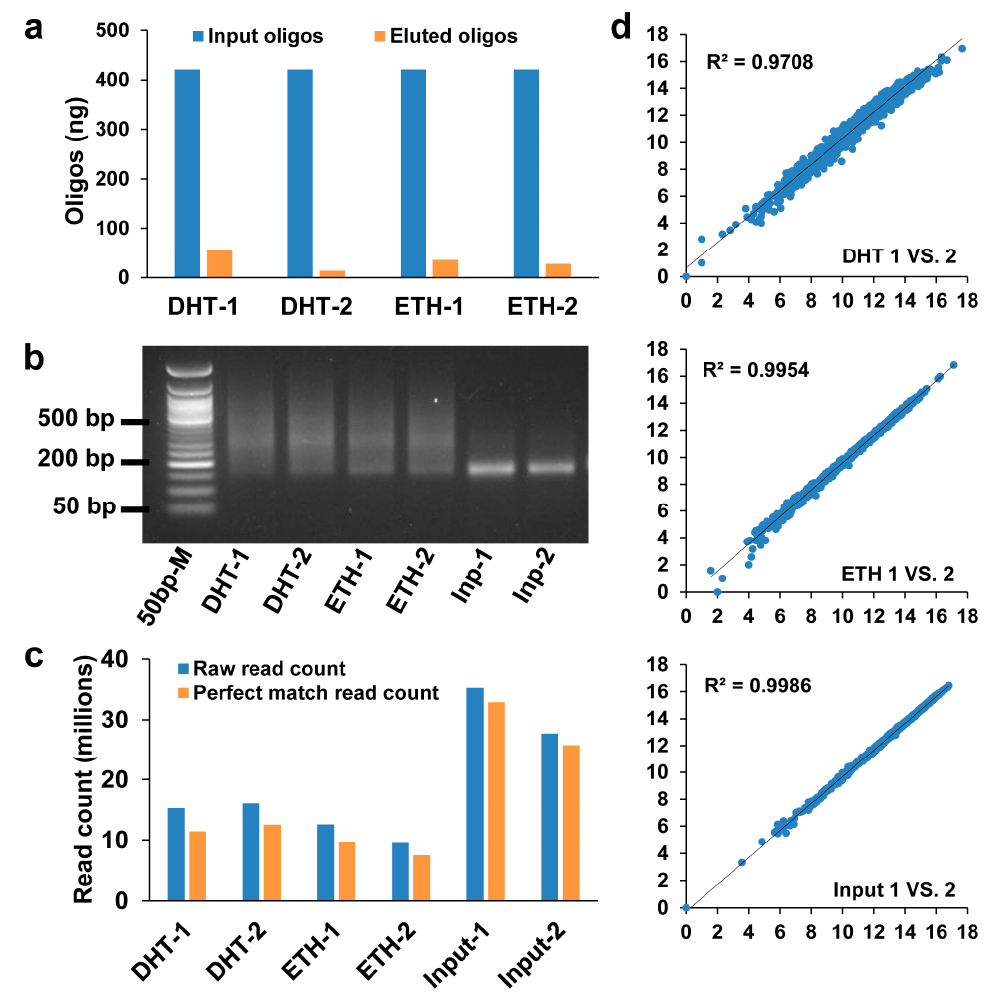
Figure 2. Quality control of SNPs-seq. ( a ) Eluted oligos after protein–DNA binding assay accounted for 3–13% of original input oligos. ( b ) Sizes of SNPs-seq libraries were ~160 bp in the input group and 150–500 bp in the test group. ( c ) Raw read counts and perfect match read counts in test and input samples. ( d ) Correlation of raw read count at log2 values between technical replicates in dihydrotestosterone (DHT), ethanol (ETH), and input